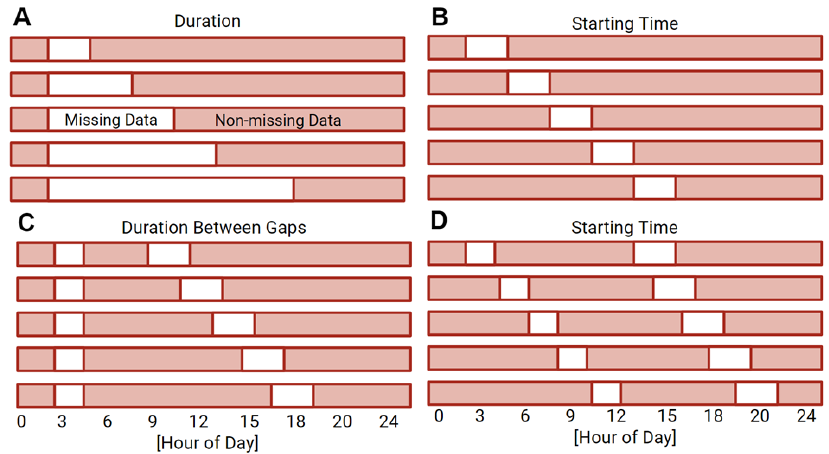
Figure 6. Mask overview. Data were systematically removed in single gaps at various durations ( A ), as well as single gaps starting at various times ( B ), while multiple gaps of missing data were varied in duration between gaps ( C ), as well as gap start time ( D ).